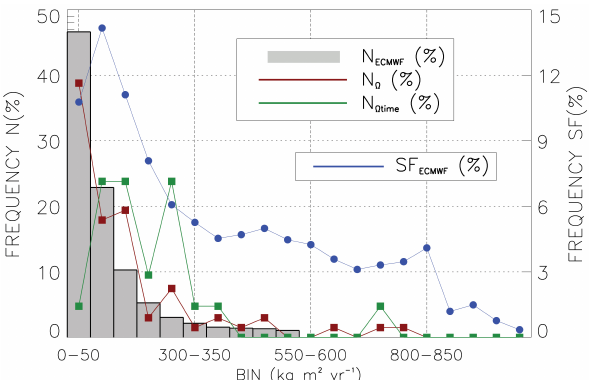
Fig. 2. Relative frequency (left side axis) of the ECMWF ERA IN- TERIM snowfall field over the Antarctica ( N ECMWF , grey-filled vertical bars) and SMB measurements for the (cid:127) ( N (cid:127) ) and (cid:127) time ( N (cid:127) time ) datasets (red and green lines, respectively) occurring in bins 50kgm − 2 yr − 1 wide. The blue line represents the contribu- tion (relative frequency, right side axis) of each bin to total snowfall over Antarctica calculated from ECMWF ERA INTERIM snowfall field (SF ECMWF )